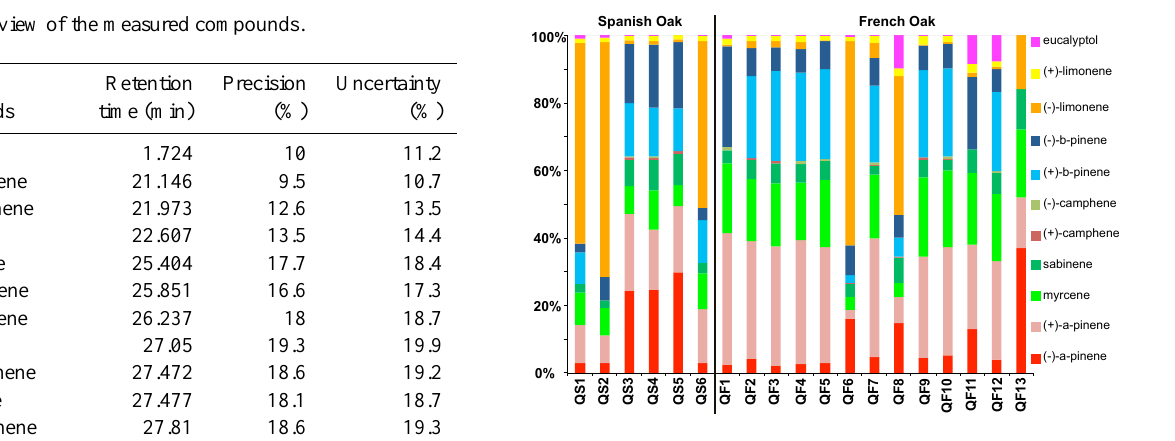
Fig. 3. Screening of Quercus ilex . L originally from different areas (southern Spain and France) at standard